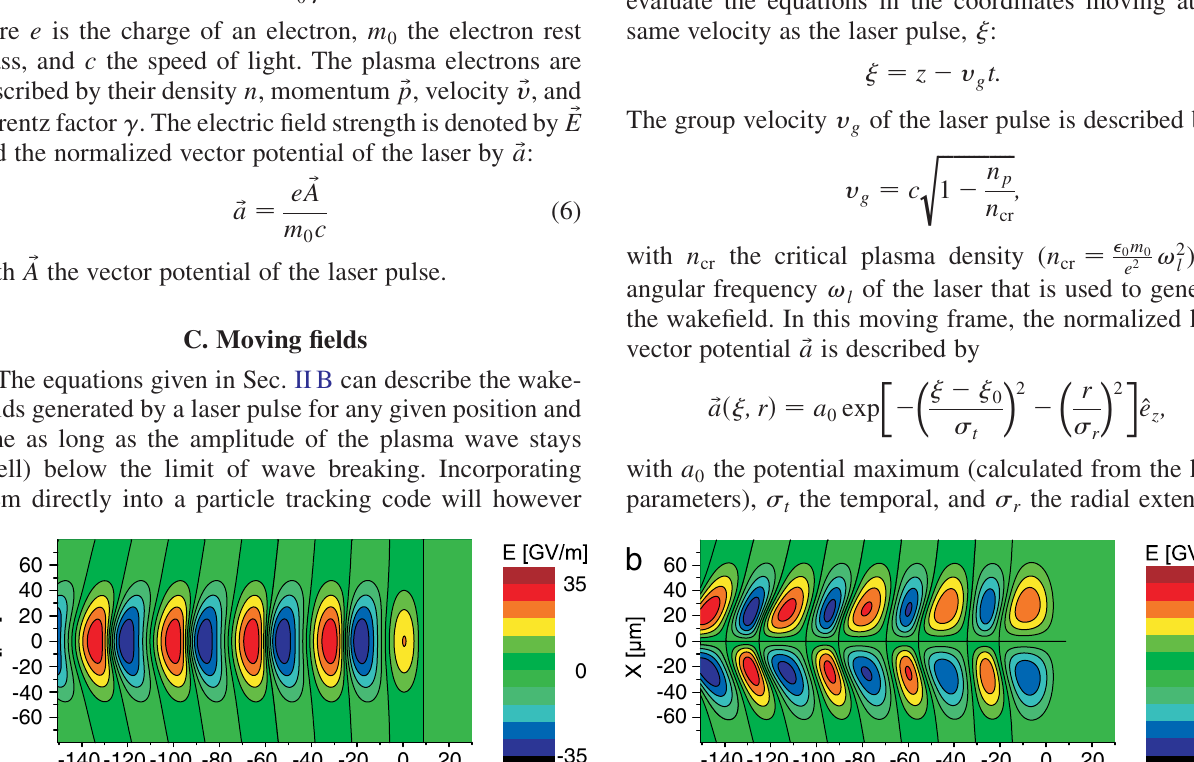
FIG. 1. (Color) Electric fields in the longitudinal (a) and radial (b) direction of a plasma wave in a plasma with n generated with laser pulse of a 0 ¼ 1 : 02 (100 TW during 50 fs matched to the matched spot size of 51 : 6 (cid:6) m ). The magnetic fields are not